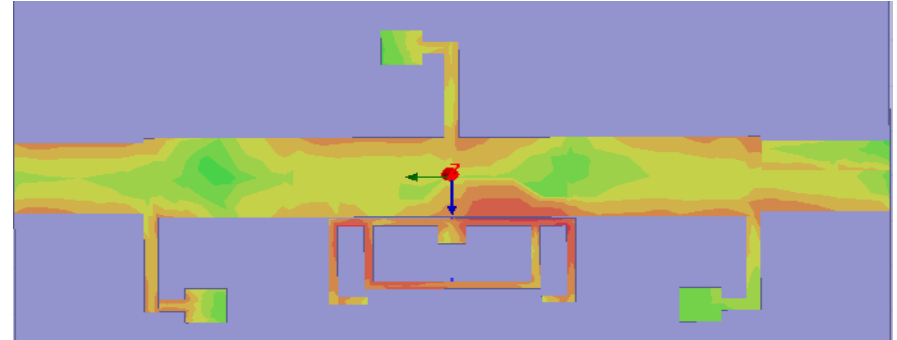
Figure 19. Current distribution graph of the triple-notched filter.